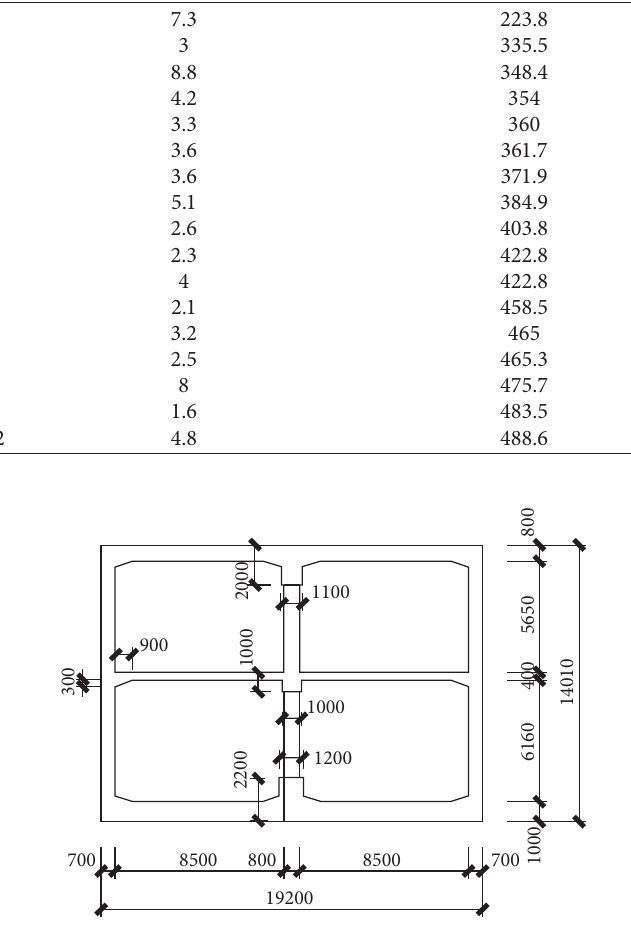
Figure 7: Schematic diagram of a typical cross section (dim.: mm).